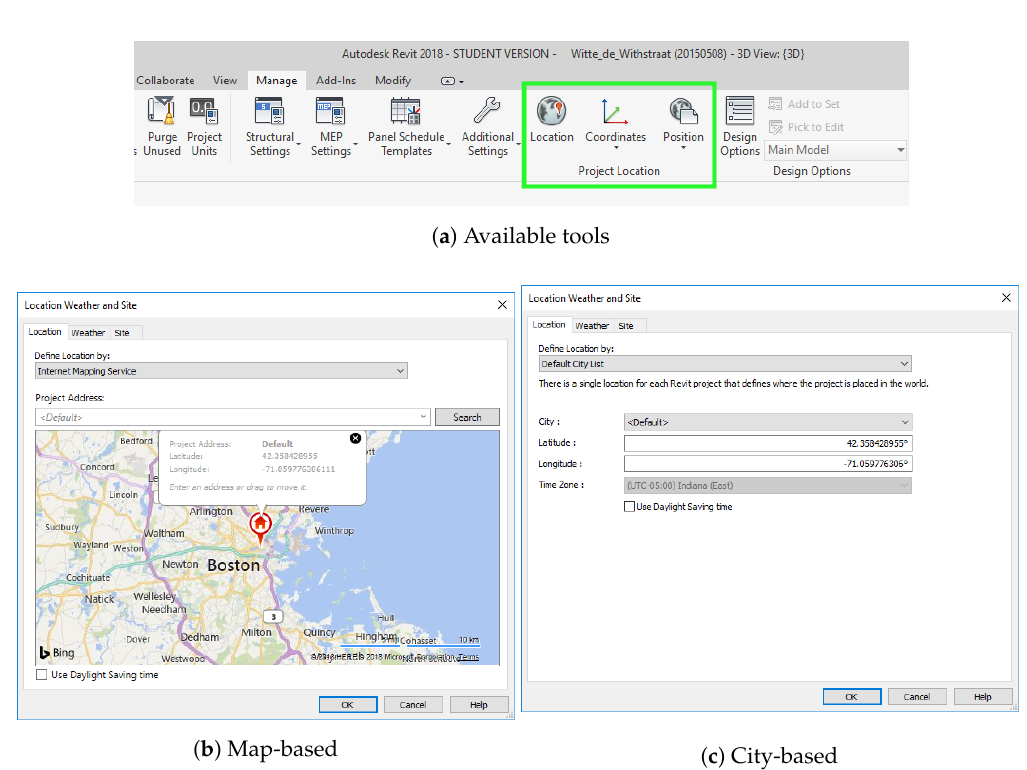
Figure 13. Tools to select a project’s location in Revit 2018.